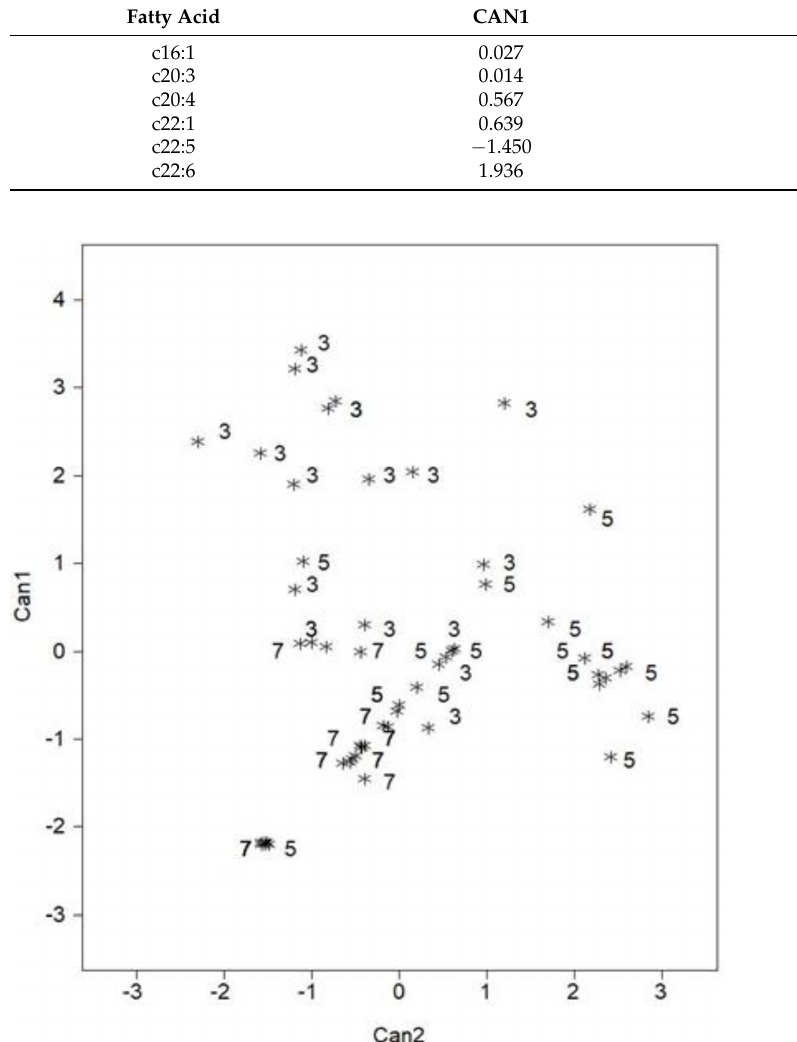
Figure 1. Scatter plot of centroids (class means) for the first and second canonical variates separat- ing the fatty acid profiles of the northern Largemouth bass whole-body samples by diet (Trial 1). Treatments designated as 1: Fed 3% (3), 2: fed 5% (5), and 3: fed 7%